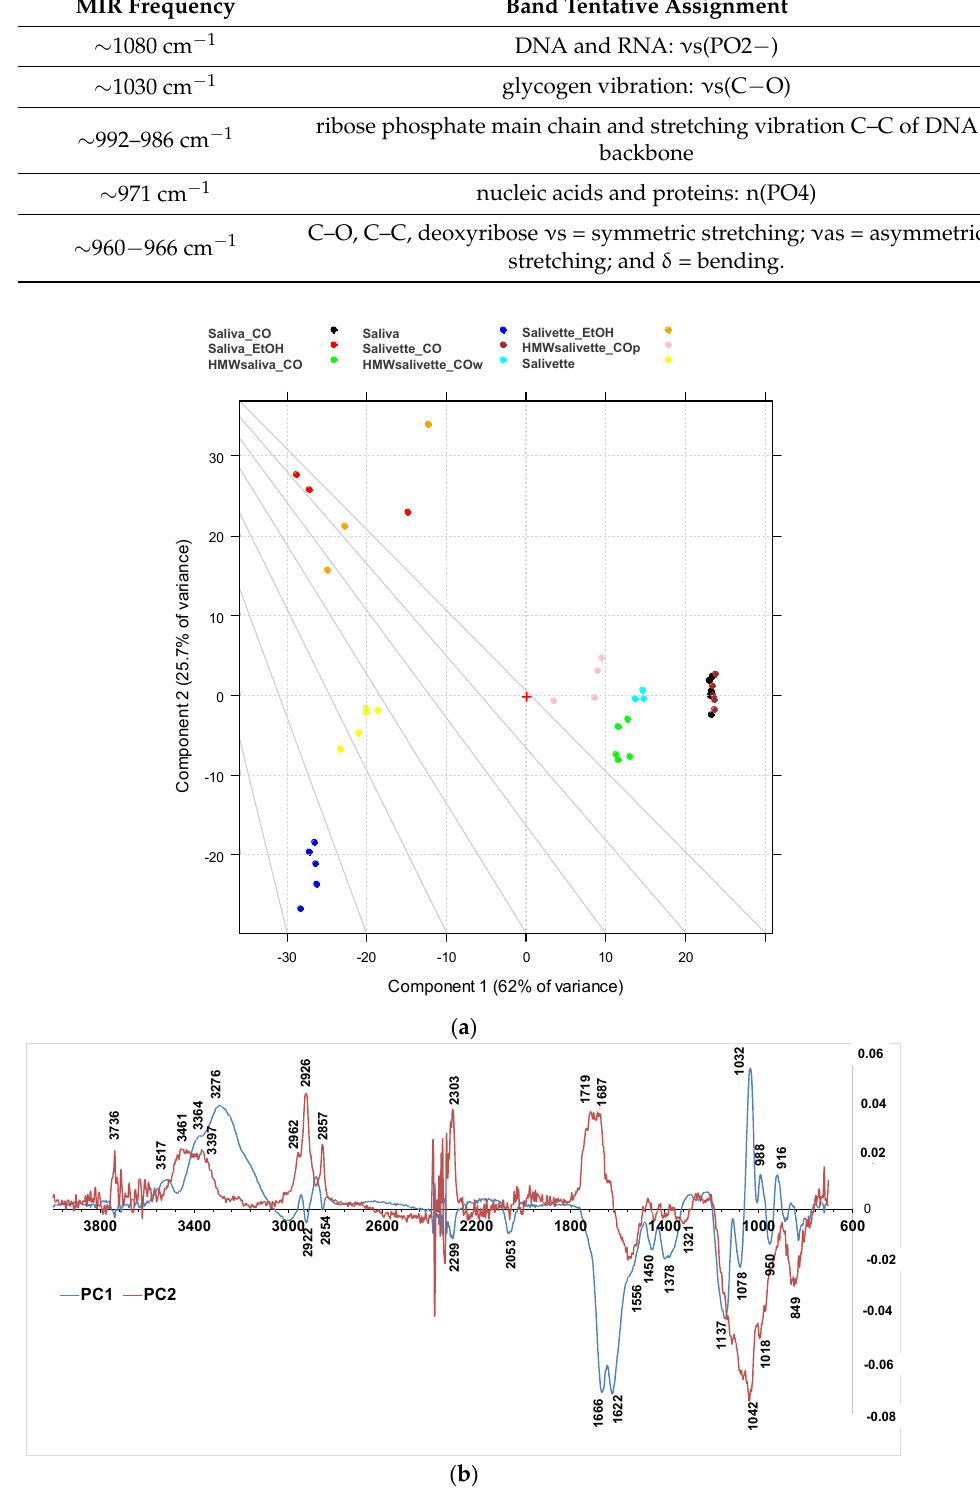
Figure 4. PCA results of SNV-normalized and centered ATR-FTIR spectra of saliva samples. ( a ) Score plot (87.7% of total variance); ( b ) loading plot of PC1 (blue line) and PC2 (red line). HMWsaliva_CO and HMWsalivette_CO refer to high-molecular-weight compounds (HMWCs) remaining in the upper part of 3 kDa cut-off filtering units (w = wiping, p = printing) as explained in the experimental part. Table 2. Principal Mid-Infrared (MIR) Bands of the Dataset and Chemical Assignments [7,10].